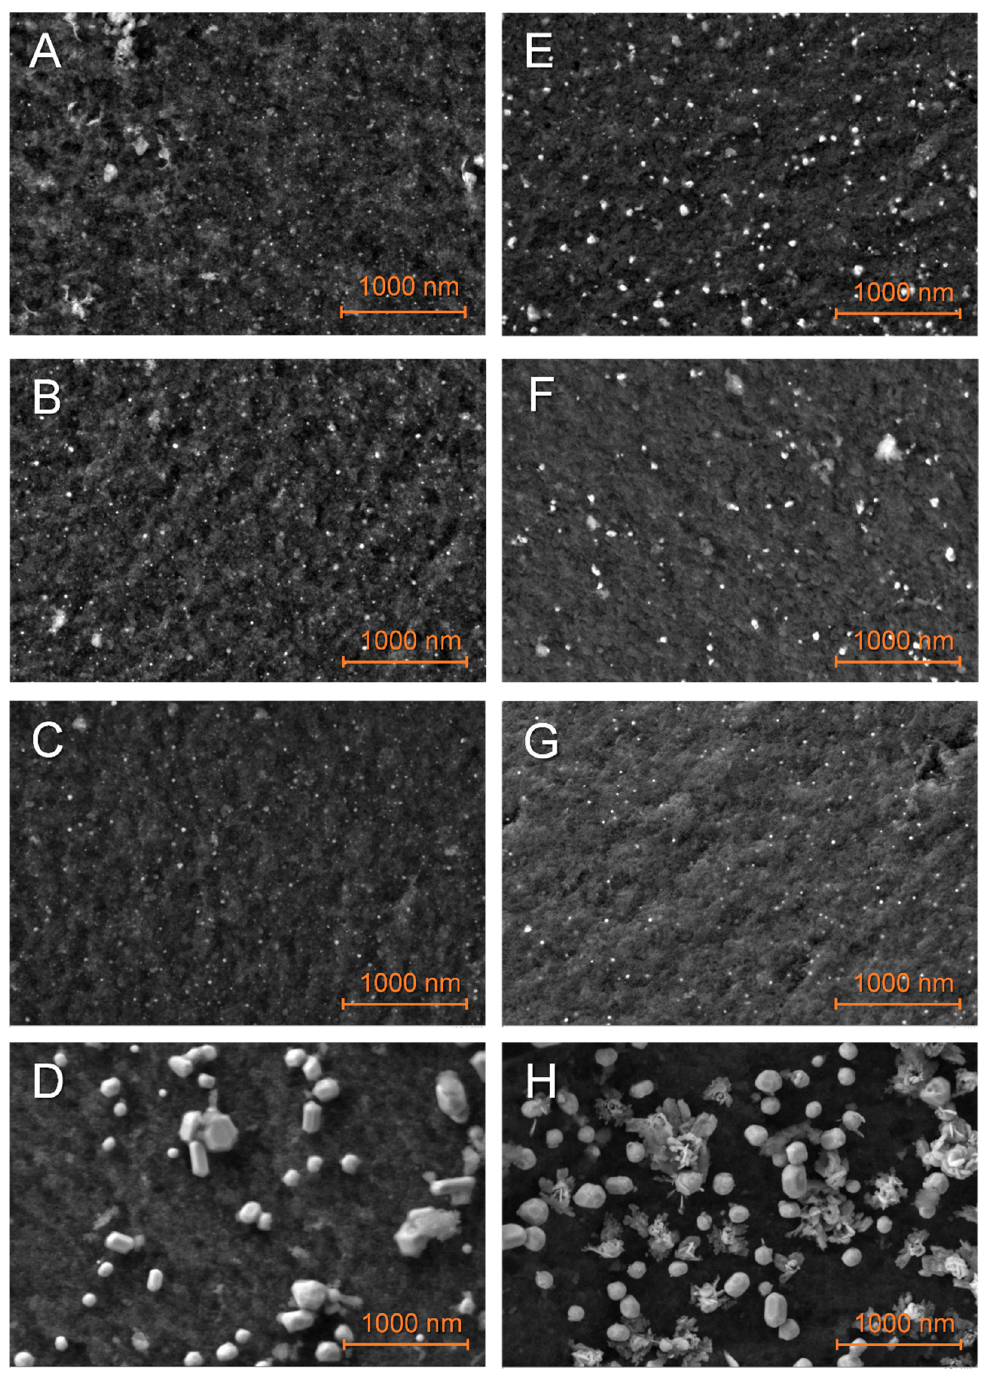
Figure 4. SEM observations of the just-impregnated GN50 ( A – D ) and G2N50 ( E – H ) matrixes deco- rated with Fe ( A , E ), Co ( B , F ), Ni ( C , G ), Cu ( D , H ) nanoparticles.